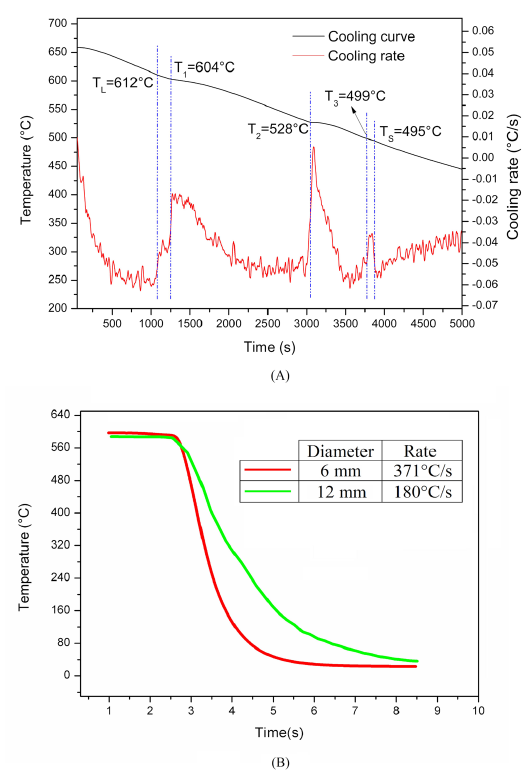
Figure 3. Thermal analysis of the experiment. (A) Correlation between the cooling curve and the cooling rate. (B) Rapid cooling curves, in detail the average cooling